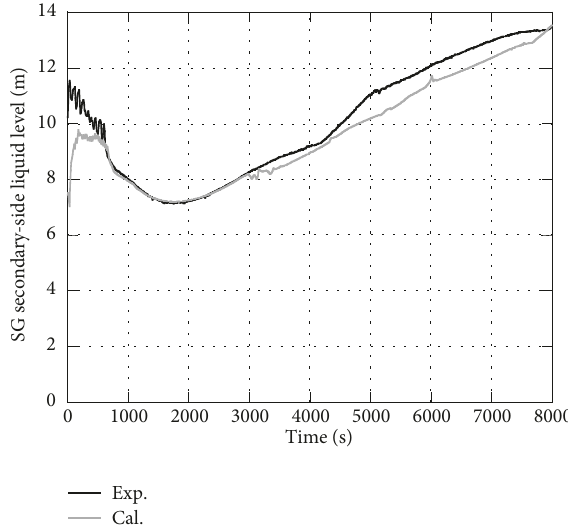
Figure 7: TR-LF-18 test and RELAP5 results for SG secondary-side collapsed liquid level in loop A.